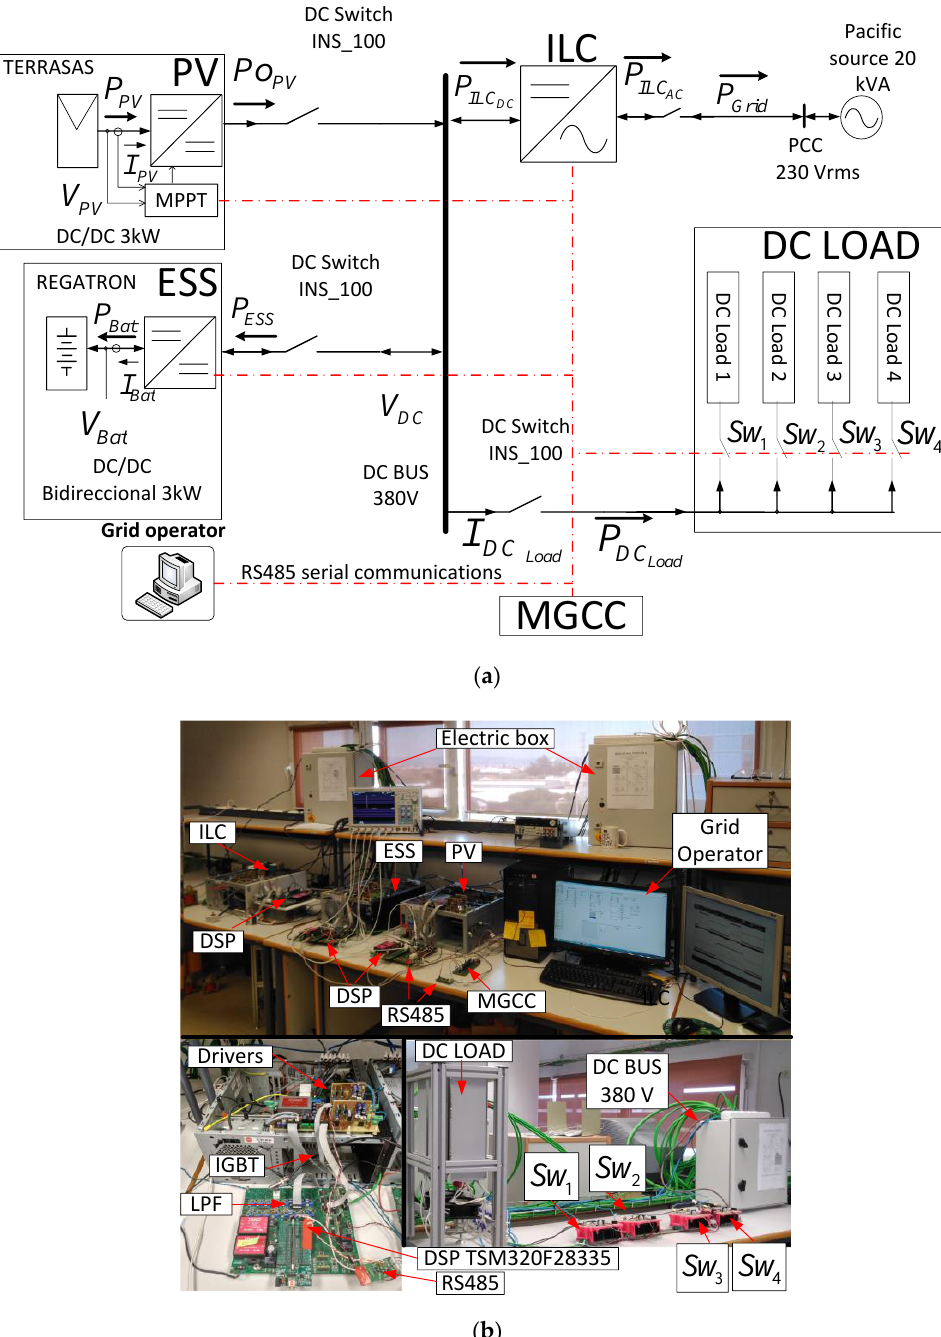
Figure 8. Experimental MG: ( a ) Schematic diagram of the experimental DC microgrid ( b ) Picture of the experimental DC microgrid.